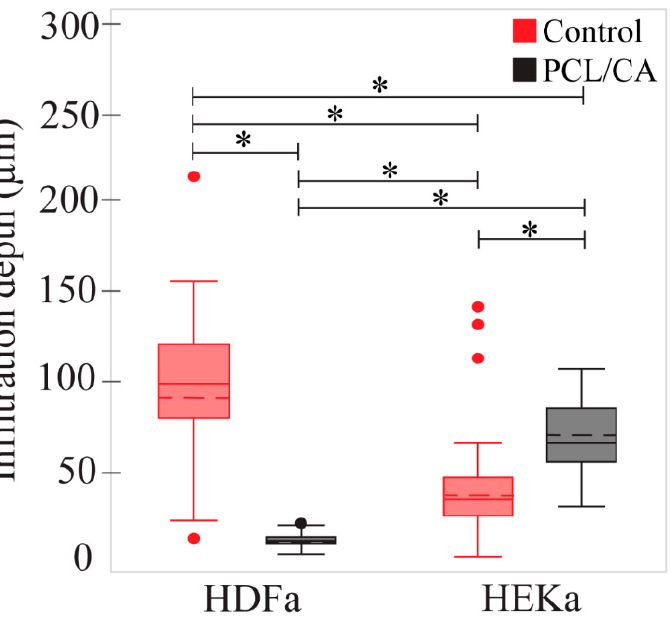
Figure 9. Statistical results of the infiltration depth of the HDFa and HEKa cells through the control and PCL/CA scaffolds. The dashed lines inside the boxes represent the means of each dataset. (*) Indicates a statistically significant difference with a confidence level of 95% ( p < 0.05).